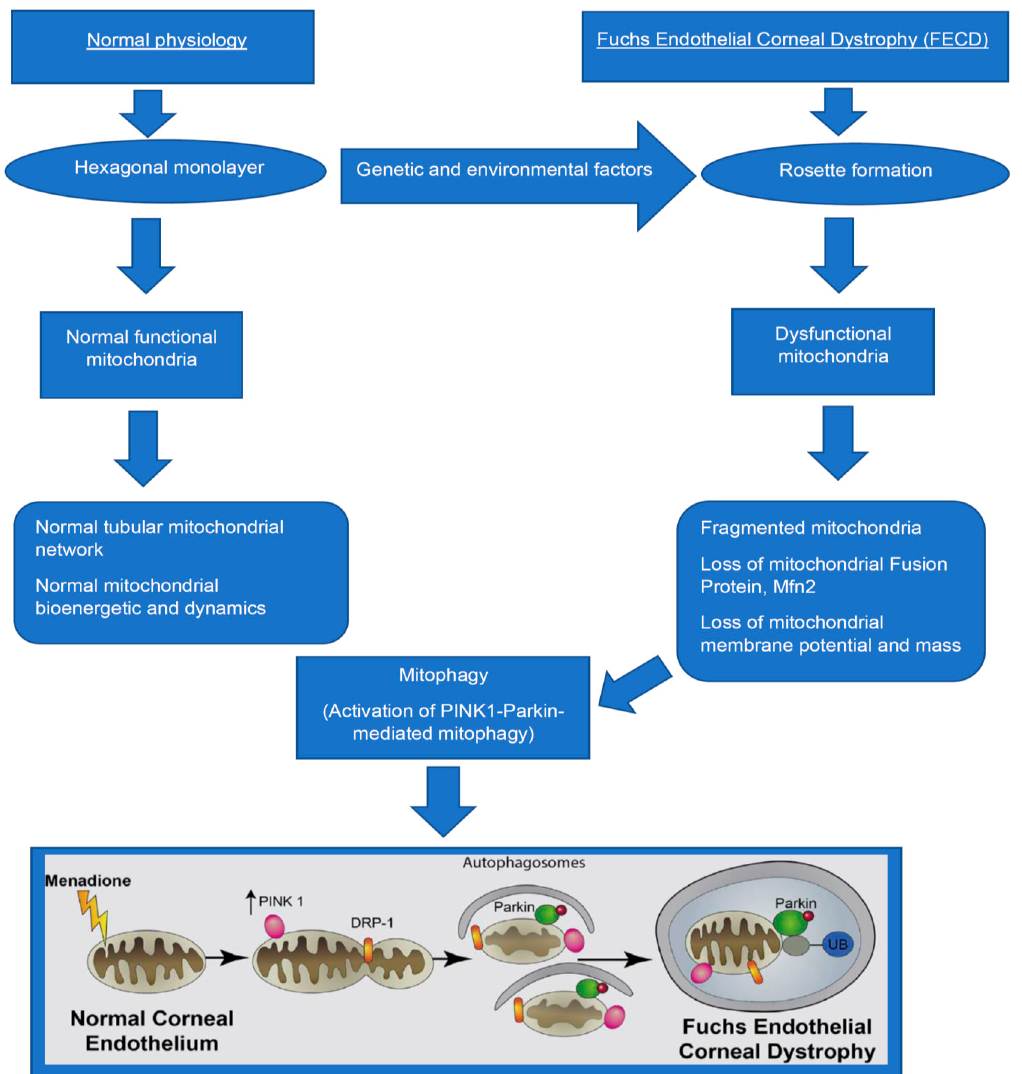
Figure 1. Mitophagy in Fuchs endothelial corneal dystrophy. Schematic diagram demonstrating the formation of dysfunctional mitochondria that leads to mitophagy in Fuchs. In FECD, various genetic and environmental factors lead to the conversion of hexagonal CEnCs into an irregular shape, thereby resulting in rosette formation. Subsequently, there is mitochondria DNA damage, fragmentation, loss of mitochondria fusion protein (Mfn2), mass and membrane potential, which lead to activation of PINK1-Parkin mediated mitophagy, thereby resulting in clearance of abnormal